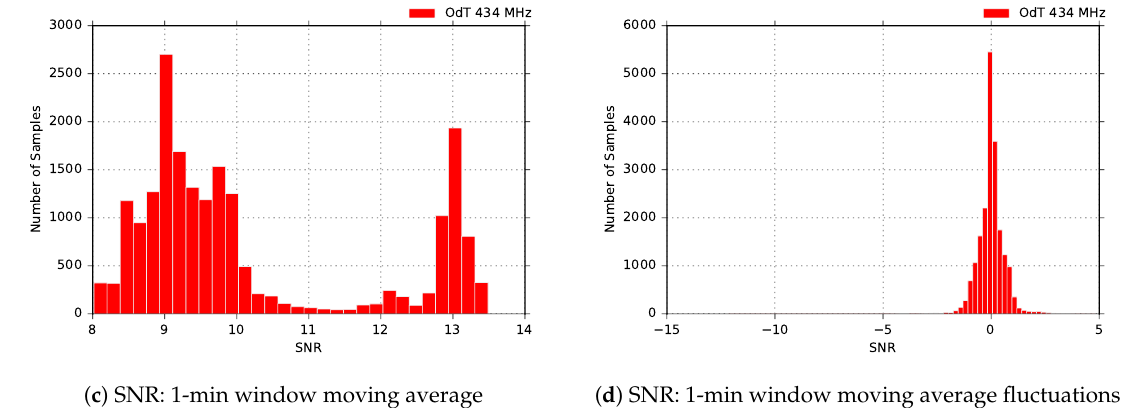
Figure 18. RSS and SNR histograms for ODT: f = 434MHz, BW = 125kHz, SF = 10, CR = 4/6,